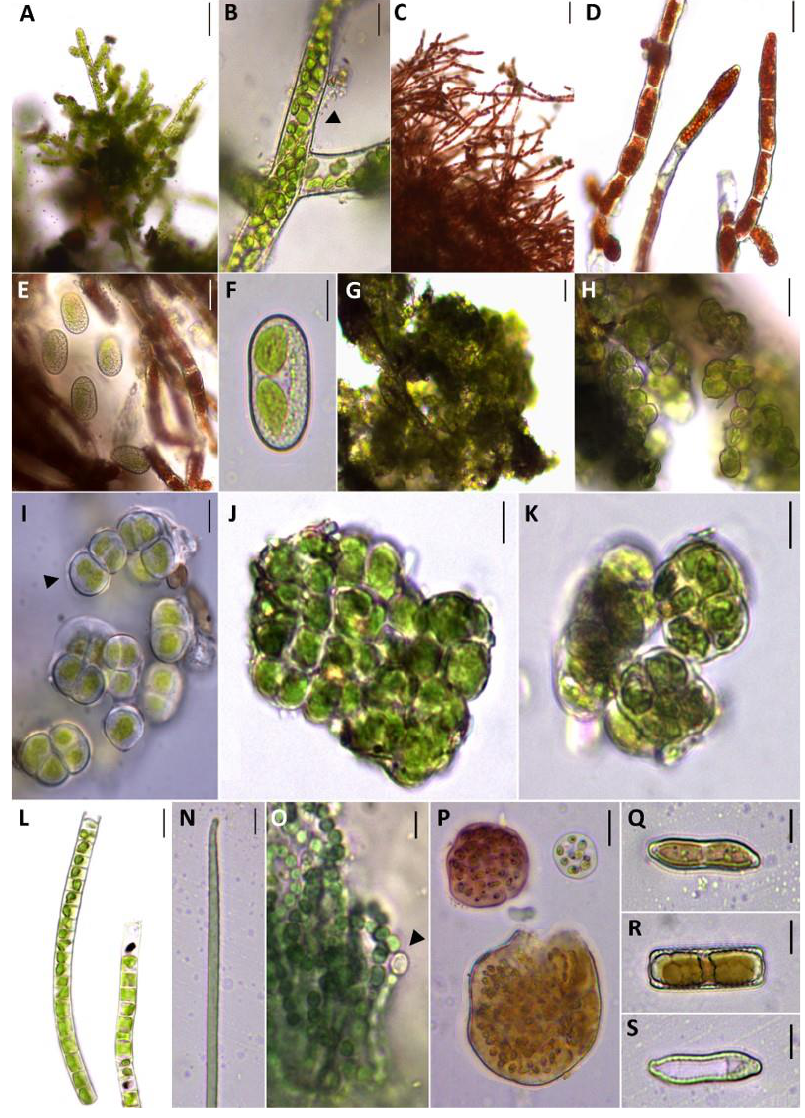
Figure 4. Taxa identified in sampled subaerial biofilms: ( A , B ) protonema of bryophyta; ( C , D ) Trentepohlia aurea (Linnaeus) C. Martius; ( E , F ) Mesotaenium macrococcum (Kützing ex Kützing) J. Roy & Bisset; ( G – I ) Apatococcus lobatus (Chodat) J.B.Petersen: diagnostic detail of the cells with bilobate chloroplast without pyrenoid indicate by arrow ( I );( J , K ) Desmococcus olivaceus (Persoon ex Acharius) J. R. Laundon; ( L ) Klebsormidium flaccidum (Kützing) P. C. Silva, K. R. Mattox & W. H. Blackwell; ( N ) Oscillatoria formosa Bory ex Gomont; ( O ) Nostoc sp. Vaucher ex Bornet & Flahault trichomes without mucilage formed by subspherical cells of 2.0-4.5 µ m in diameter and heterocytes indicated by an arrow; ( P ) Gloeocapsa punctata Nägeli; ( Q – S ) Hantzschia amphioxys (Ehrenberg) Grunow. Scale bar = 50 µ m ( A , C , G ); 20 µ m ( E , H ); 10 µ m ( B , D ); 5 µ m ( F , I , K , L – S